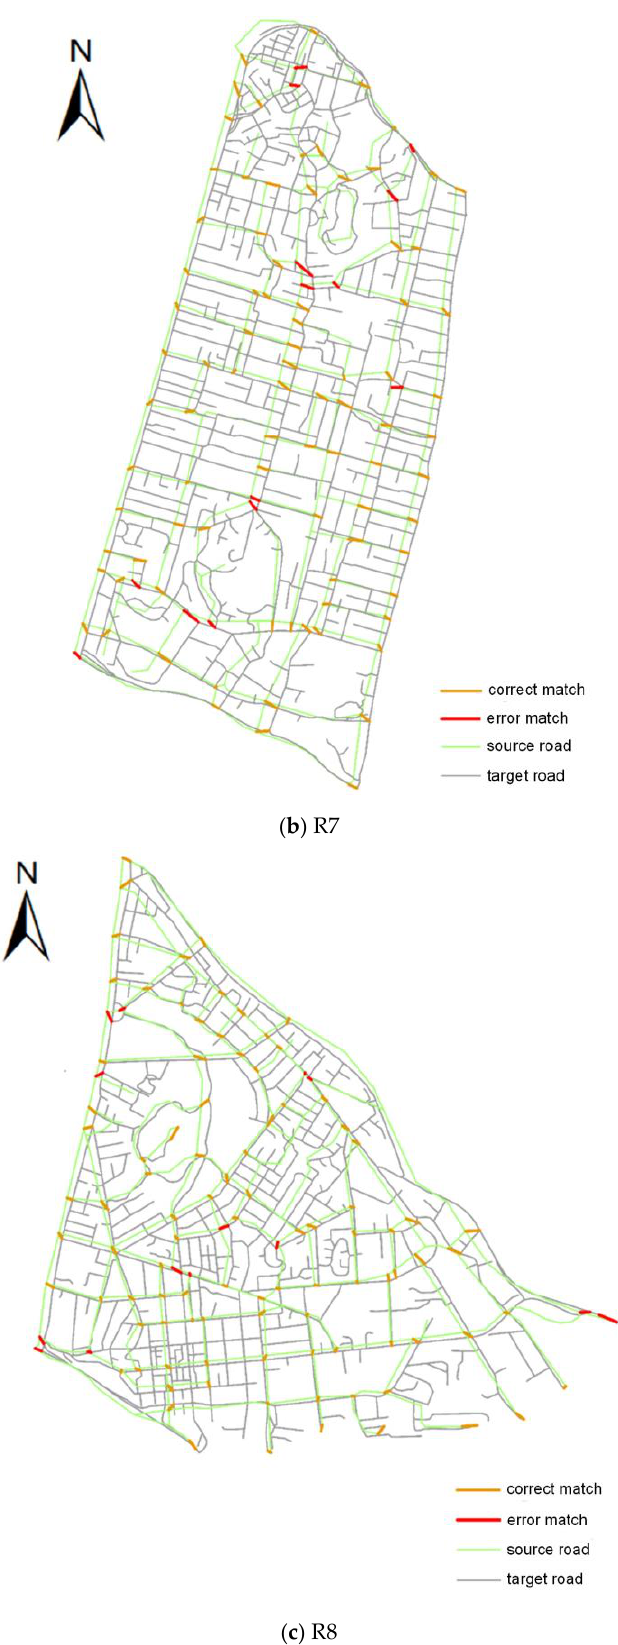
Figure A3. Matching results of DRTM for the three subregions of Area 3 (R6, R7, and R8). ( a ) Matching result of R6, ( b ) matching result of R7, and ( c ) matching result of R8.